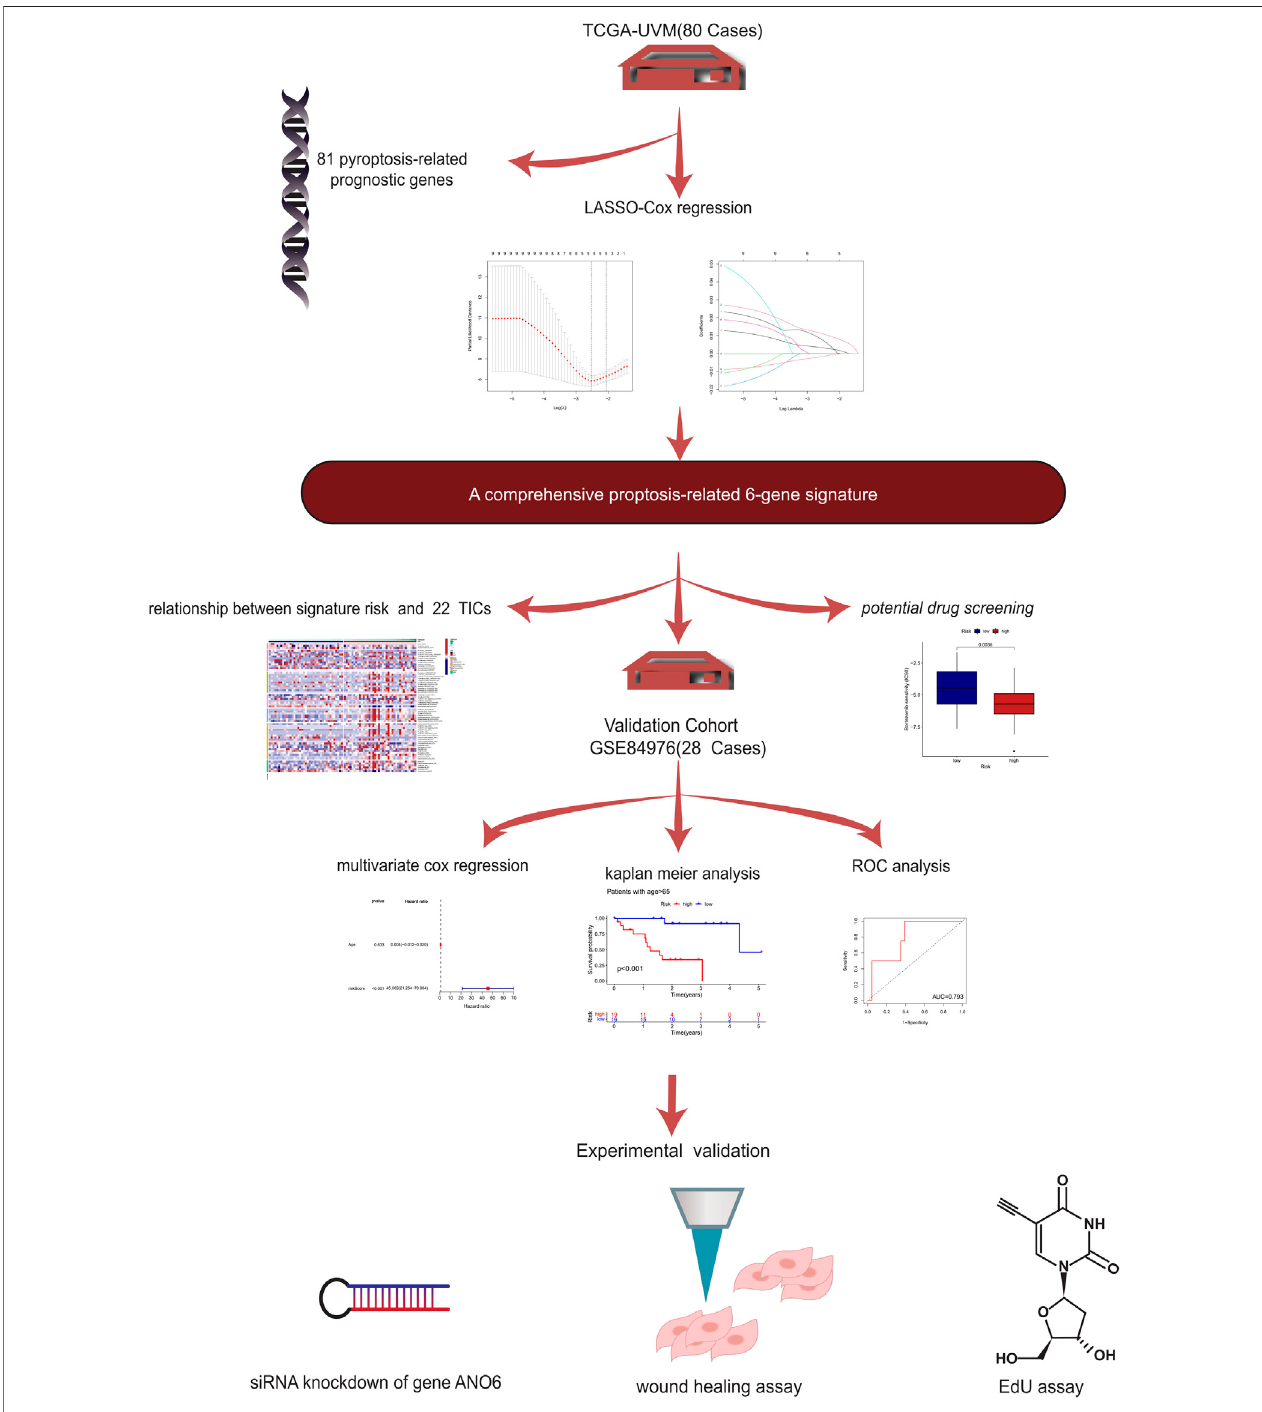
FIGURE 1 | The fl ow